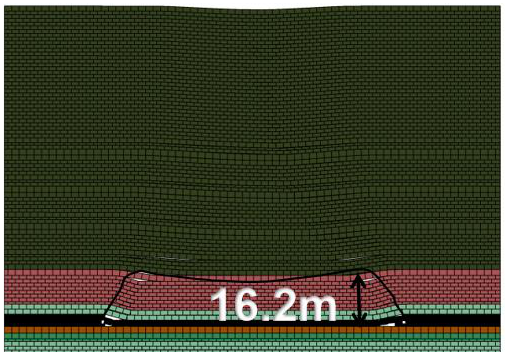
Figure 10. Simulation results of collapsed mine with insufficient